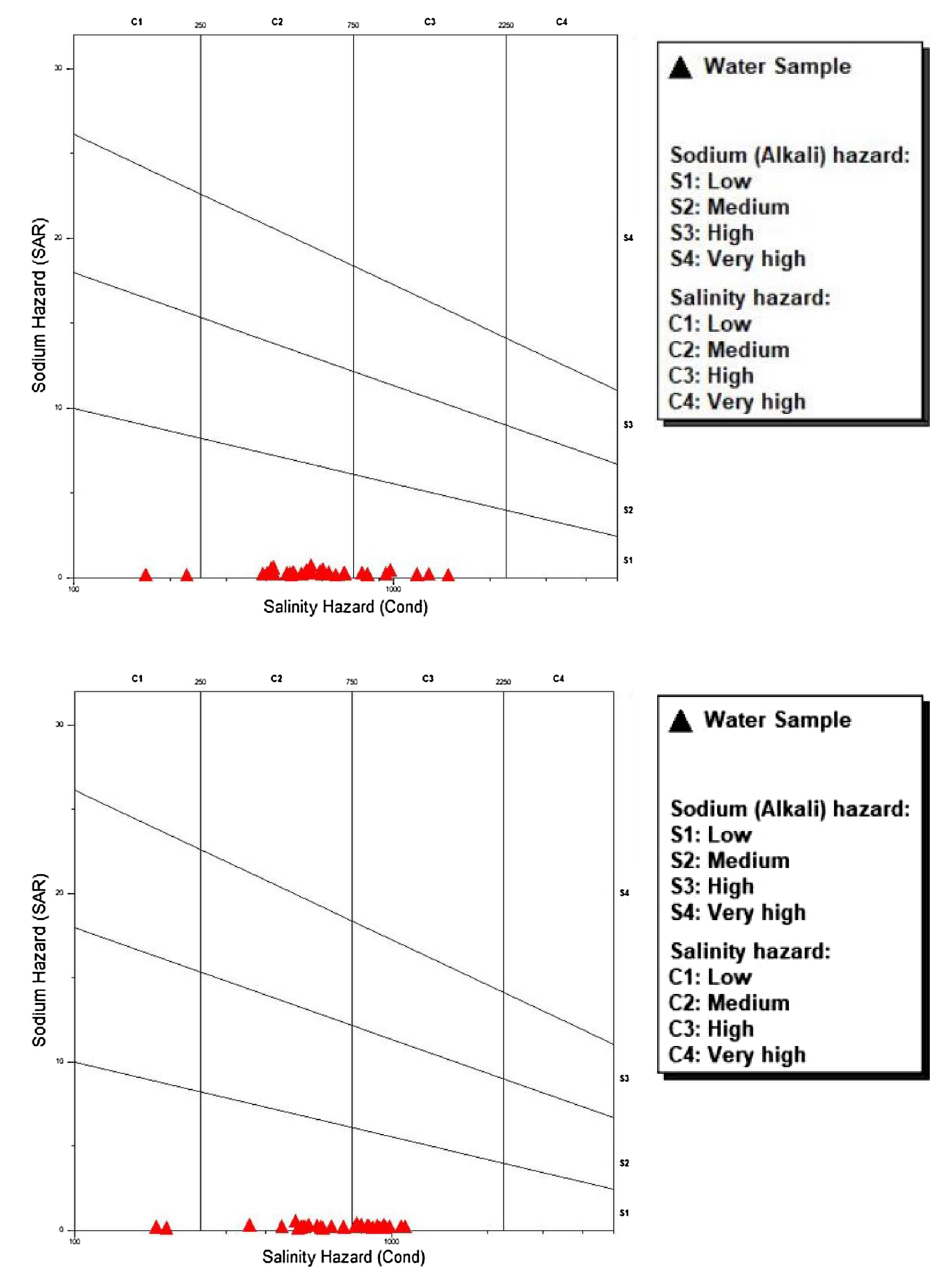
Fig. 38 USSL diagram (pre- monsoon)